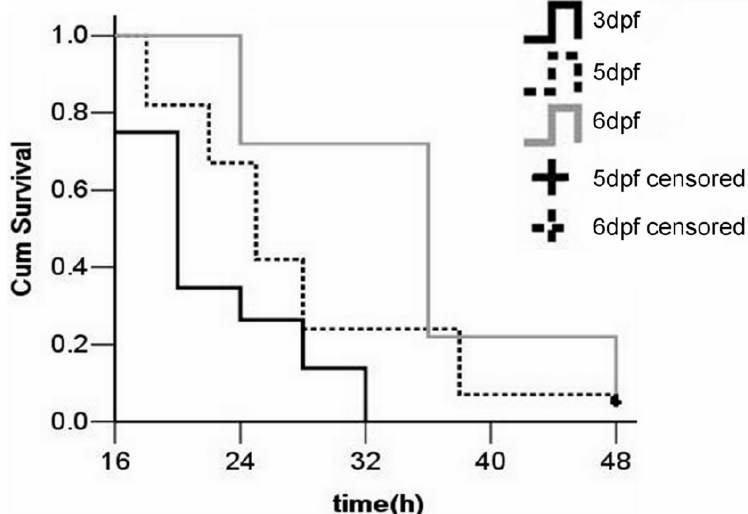
Figure 6. Average cumulative mortality (percent) of zebrafish larvae injected with LPS at different stages. Two-hundred larvae were randomly divided into four groups ( n = 50 for each). 0.5 mg/mL LPS was injected into the yolk at 3-, 5-, and 6-dpf, and larvae were then monitored for 48 h. Larvae injected with PBS served as negative controls. Each curve represents data pooled from three independent